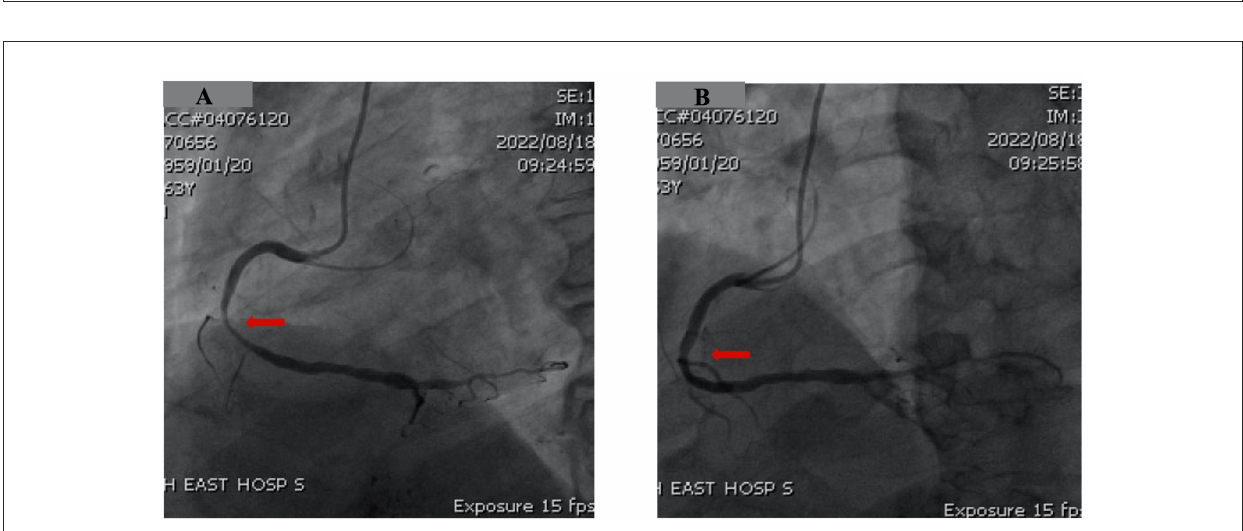
FIGURE4 Follow-up coronary angiography showed severe stenosis of the right coronary artery ( A , red arrow). After administration of intracoronary nitrates, a significant recovery of vessel patency was observed (B) , and a diagnosis of epicardial spasm was made ( B , red arrow).